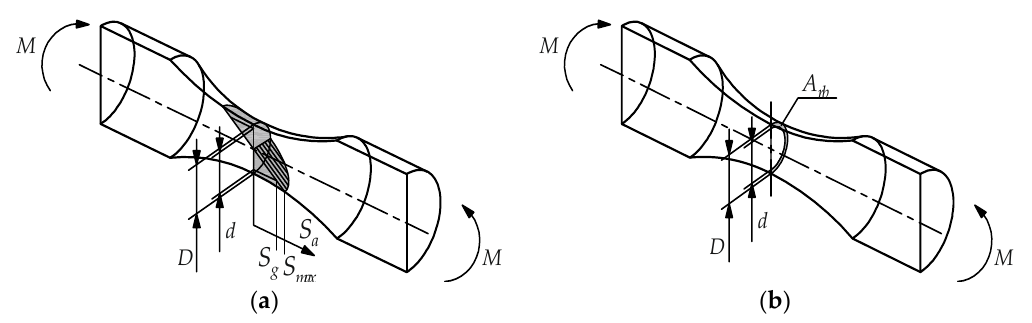
Figure 2. Bending specimen: ( a ) stress distribution, ( b ) surface area A rb .